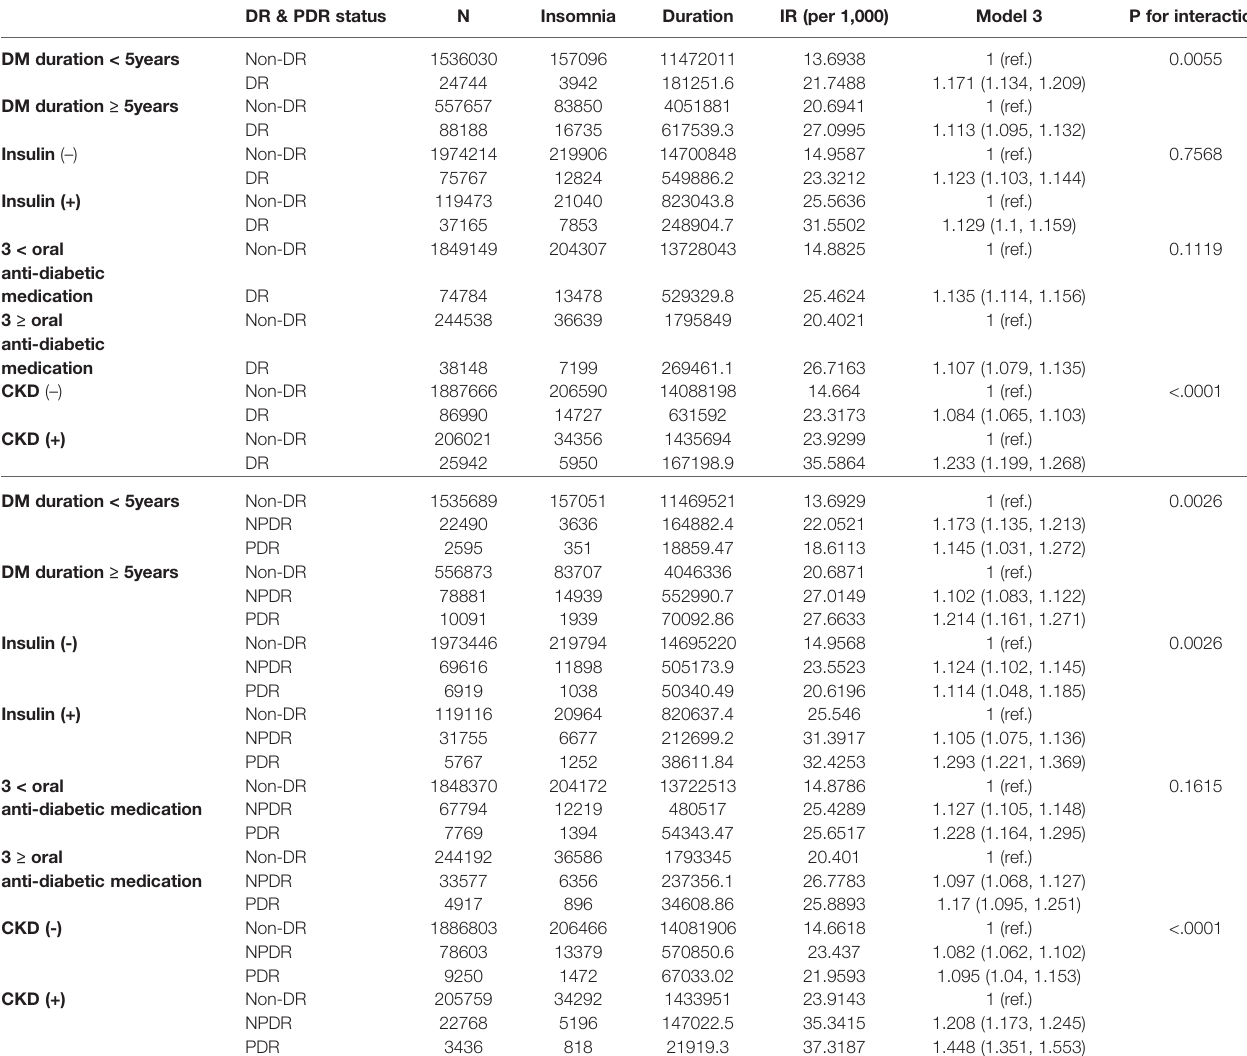
TABLE 4 | Incidence rate (IR) and risk of insomnia in diabetic retinopathy (DR) and proliferative diabetic retinopathy (PDR) with consideration for the interactive effect of diabetes mellitus (DM)-related